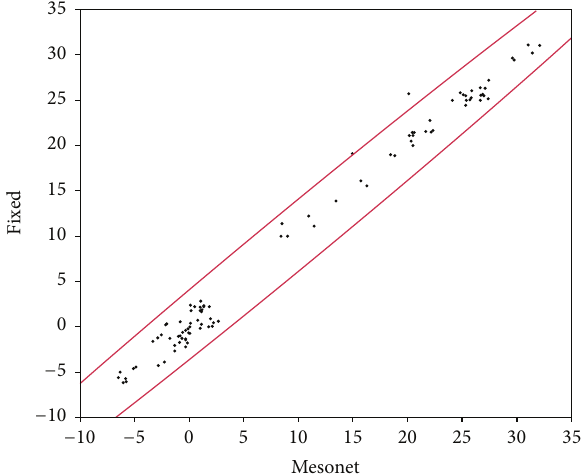
Figure 11: Correlation between the temperatures ( ∘ C) of fixed weather stations and mobile mesonet